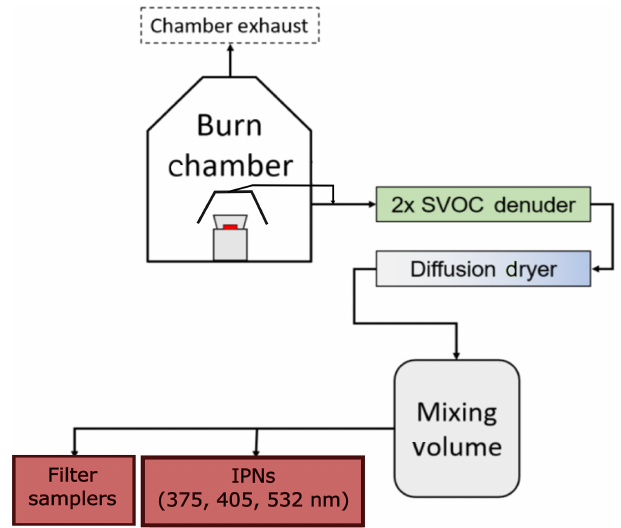
Figure 4. Schematic representation of the experimental setup. In- let to the semi-volatile organic compound denuder was taken from either the chamber sampling port or the hood. “IPNs” denotes the integrated photoacoustic-nephelometer